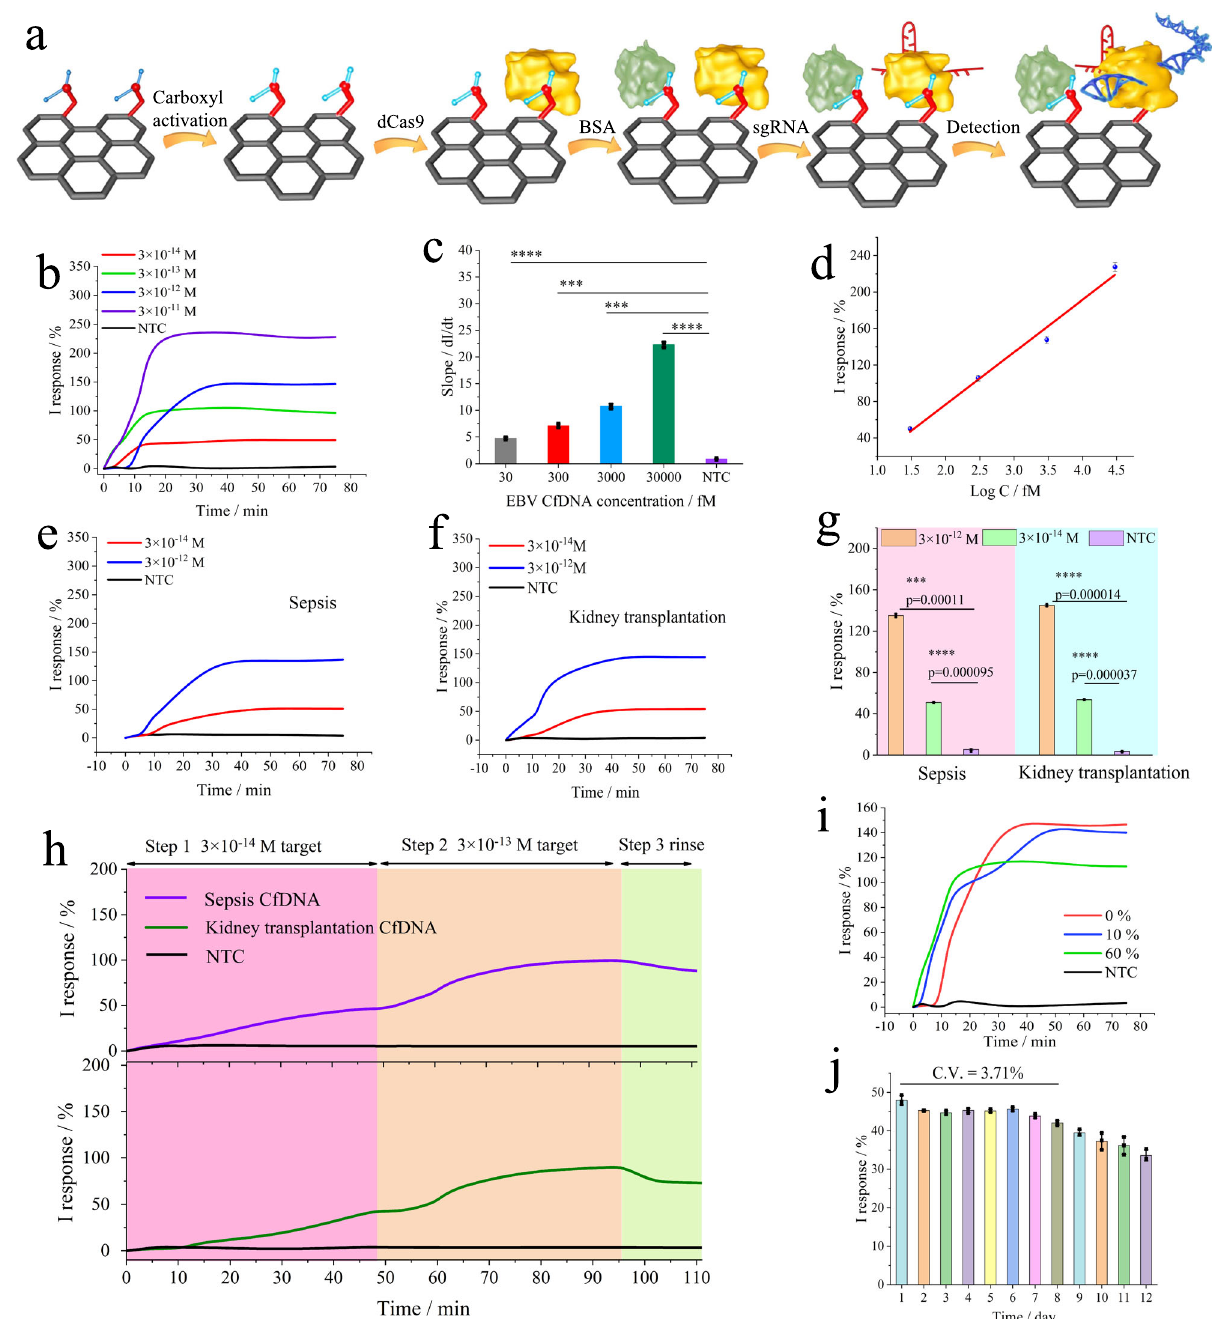
Fig. 5 Analytical performance of CRISPR MN targeting different cfDNA in vitro. a Schematic of CRISPR MN preparation. b Real-time CRISPR MN I response targeting variable concentrations of EBV cfDNA, in the presence of the simulated ISF solution. c Slope values of different target detection, data collected from the curve peak of the real-time curve calculated by simple differentiation, the slope of EBV cfDNA target compared with no target control (NTC) using two-way ANOVA: * p < 0.05, ** p < 0.01, *** p < 0.001, **** p < 0.0001, p value of 0.000092, 0.00038, 0.00027, 0.000096 for 30, 300, 3000, 30000 fM target DNA respectively, data presented as mean values ± SD, n = 3 independent experiments. d Standard calibration curve of the real-time I response from ( b ), data presented as mean values± SD, n = 3 independent experiments. e Real-time CRISPR MN I response targeting variable concentrations of sepsis cfDNA, in the presence of the simulated ISF solution. f Real-time CRISPR MN I response targeting variable concentrations of kidney transplantation cfDNA, in the presence of the simulated ISF solution. g Signal response for sepsis cfDNA and kidney transplantation cfDNA in vitro including 3 × 10 − 12 M, 3 × 10 − 14 M, NTC, using two-way ANOVA: * p < 0.05, ** p < 0.01, *** p < 0.001, **** p < 0.0001, data presented as mean values ± SD, n = 3 independent experiments. h Dynamic change of sepsis cfDNA and kidney transplantation cfDNA recording by CRISPR MN platform, steps 1 – 3 referring to real-time monitoring of 3 × 10 − 14 M target cfDNA, 3 × 10 − 13 M target cfDNA, rinsed by TE buffer (37 °C, pH 8.0). i Anti-interference ability of the CRISPR MN for 3 × 10 − 12 M EBV cfDNA in the presence of various concentrations of fetal bovine serum. j The stable sensitivity of the CRISPR MN in vitro for 12 days, the CRISPR MN incubated in stimulated tissue and monitoring 3 × 10 − 14 M target cfDNA on a skin chip under reverse iontophoresis (10 V), data presented as mean values± SD, n = 3 independent experiments.